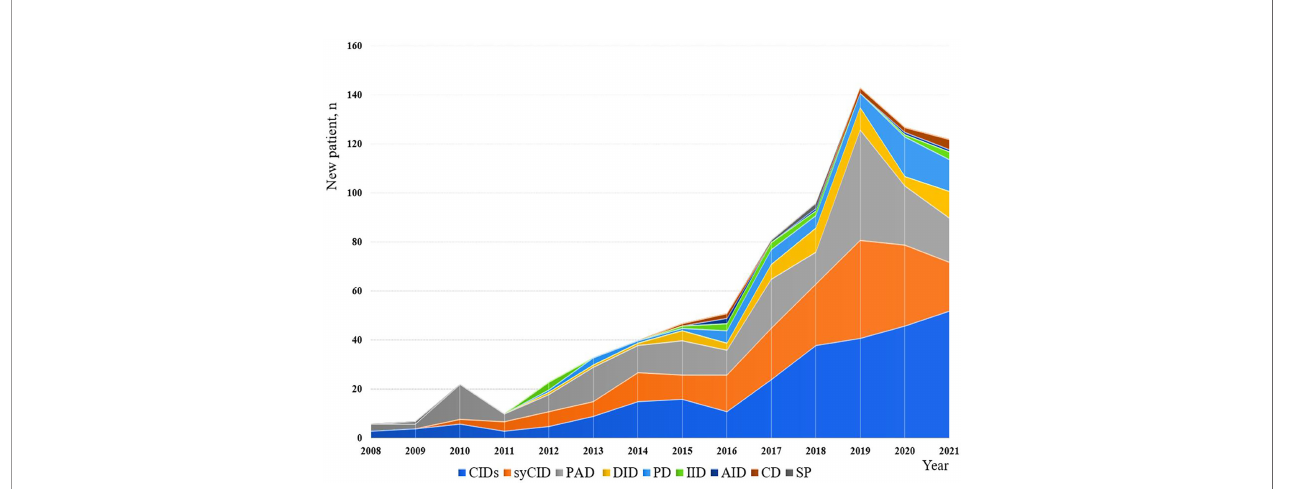
FIGURE 4 | Annual numbers of newly diagnosed IEI cases from 2008 to September 2021. The registration of patients into the database has been stopped in September for the year 2021.